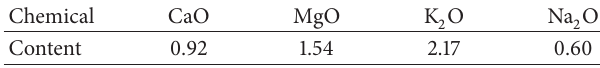
Table 2: Soluble chemical composition of soil sample (wt.%).